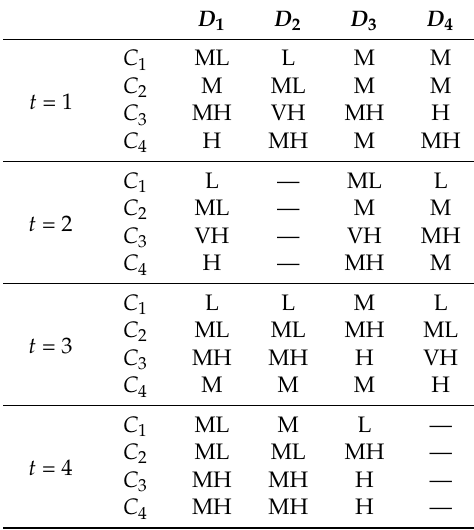
Table 6. The matrices of criteria weights in different